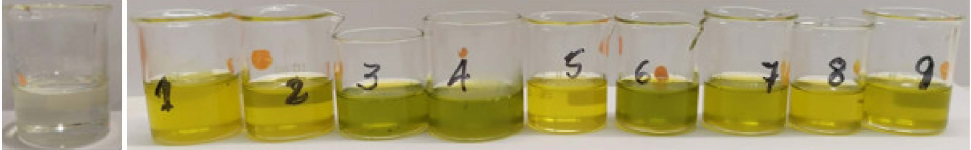
Figure 2. Samples of original (first sample) and supplemented sunflower oil samples with C. maritimum extracts by UAE. The extraction conditions of supplemented samples 1 to 9 corre- spond to those presented in Table